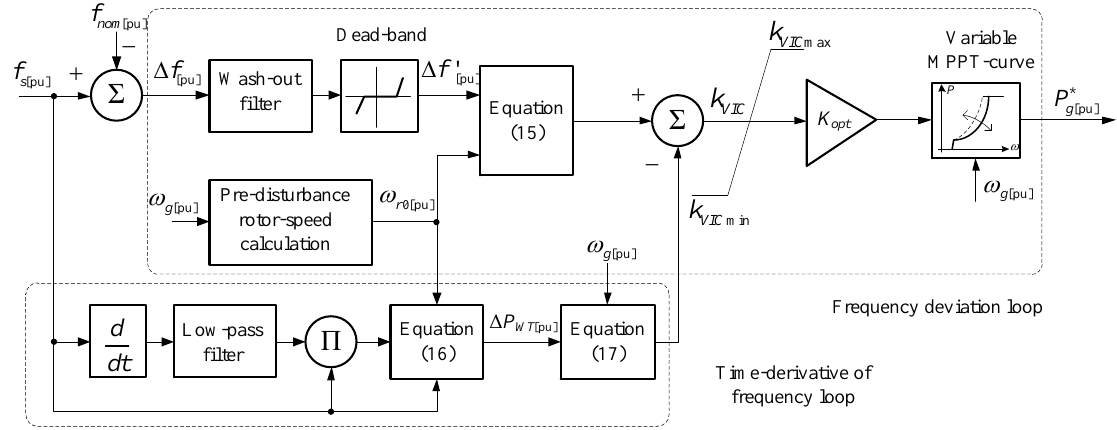
Figure 8. Scheme of the virtual inertia algorithm implemented in the variable speed wind turbine.